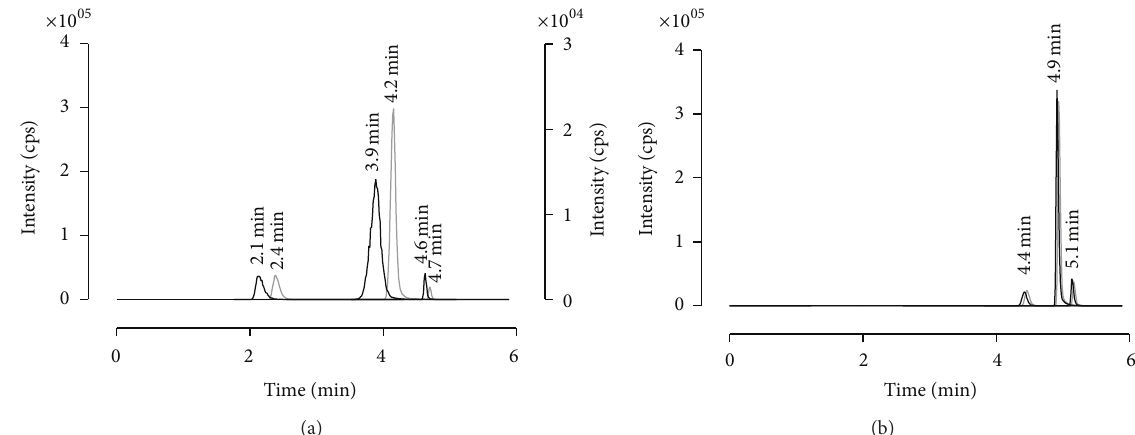
Figure 5: Multiple reaction monitoring scan chromatograms of enalapril, enalaprilat, and benazepril. The left graph illustrates the shift in retention time detected by comparing the analytes solved in mobile phase versus the analytes in purified matrix during first extraction attempts. Right graph shows the final chromatogram by comparing also the analytes in mobile phase versus analytes in purified serum. A timely shift in retention time was not detectable anymore. MRMs: 377.2 → 234.2 m/z (enalapril), 349.1 → 206.1 m/z (enalaprilat), and 425.3 → 351.2 m/z (benazepril). The black line identifies the extracted serum samples and the grey line illustrates the drug substances dissolved in mobile phase. Cps: counts.